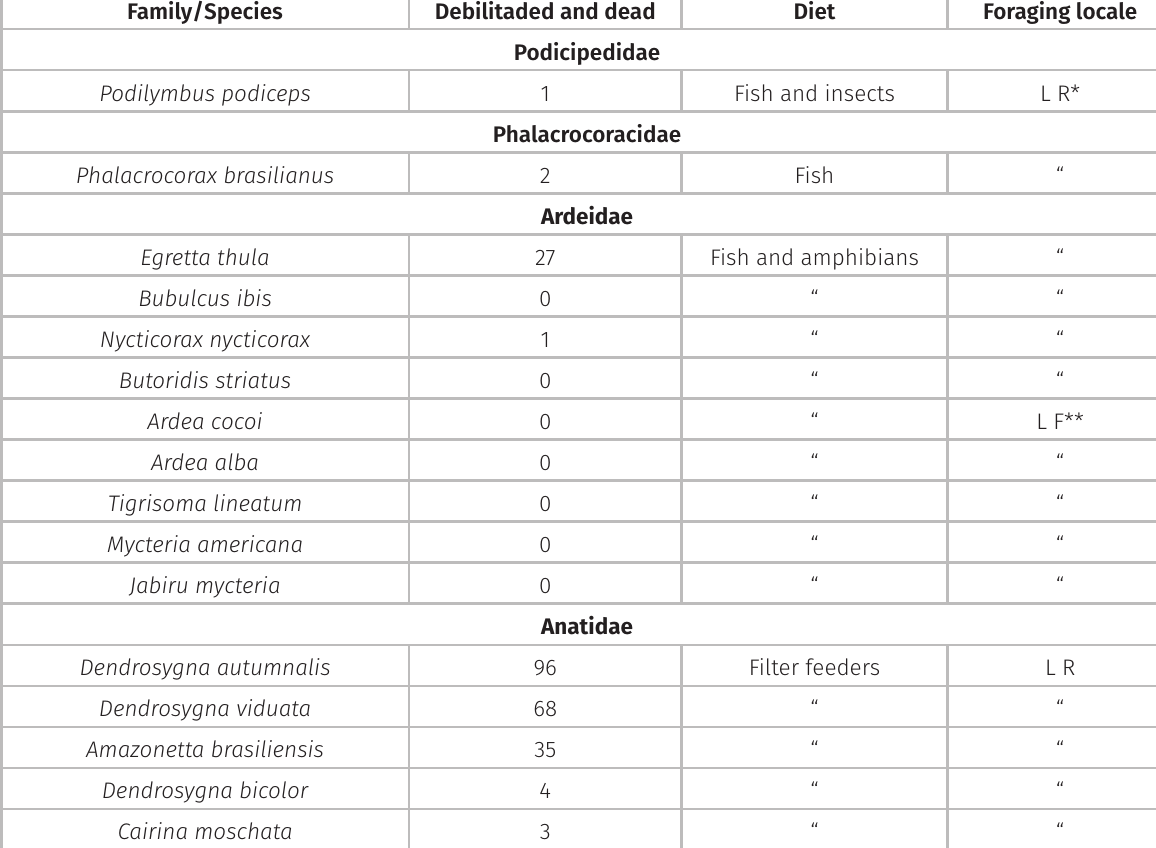
Table I. Families and species of birds identified in the study area, discriminated by number of individuals debilitated and dead, feeding habits and foraging locale in relation to the water depth of the small lakes near to the Holding Lake of the Sobradinho Dam; in the municipality of Remanso, Bahia in